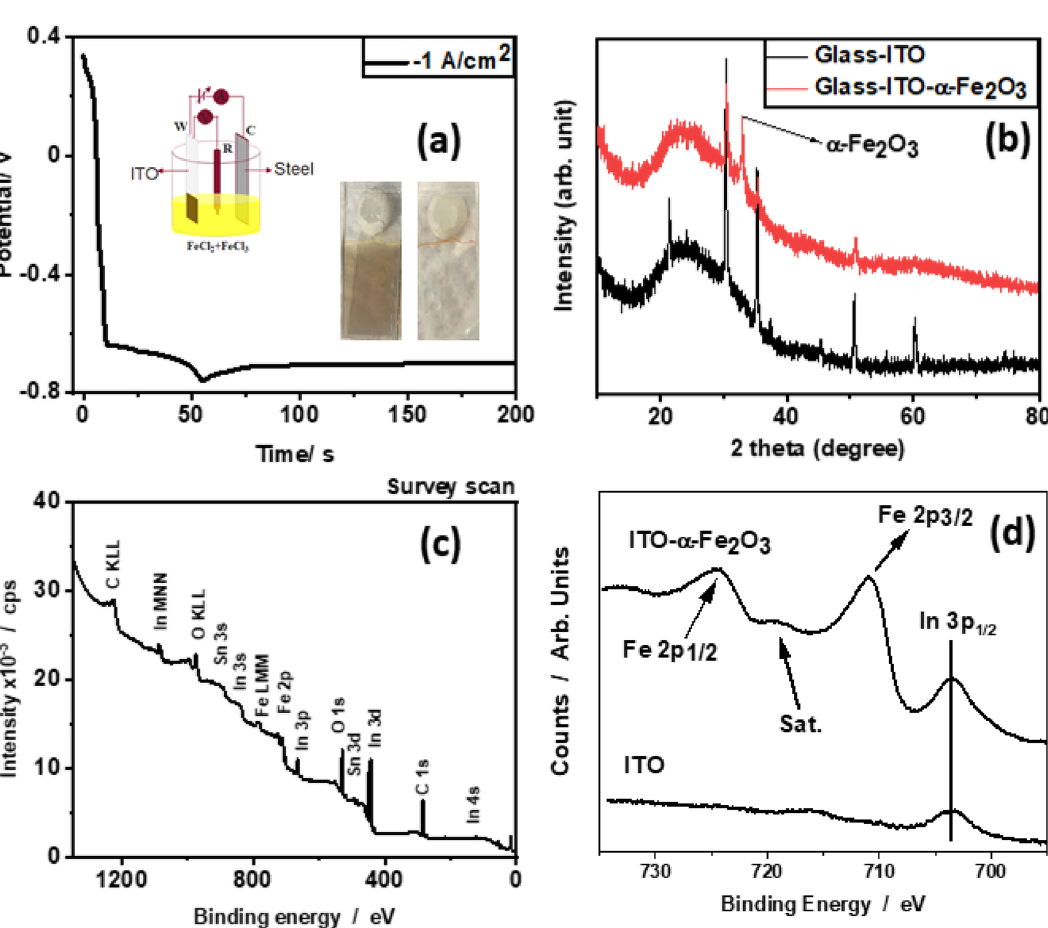
Figure 2. ( a ) Chronopotentiometry curve of α-Fe 2 O 3 deposition at − 1 mA cm −2 current density. (Inset-optical images of the resultant film before annealing (left) and after annealing (right)), ( b ) XRD patterns of ITO-glass and α-Fe 2 O 3 on ITO-glass, ( c ) XPS survey spectrum of α-Fe 2 O 3 on ITO-Glass and ( d ) XPS spectra of In 3p and Fe